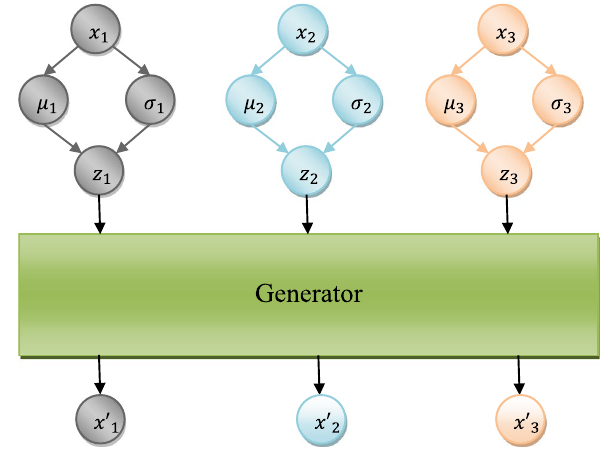
Fig. 2 Diagram of VAE